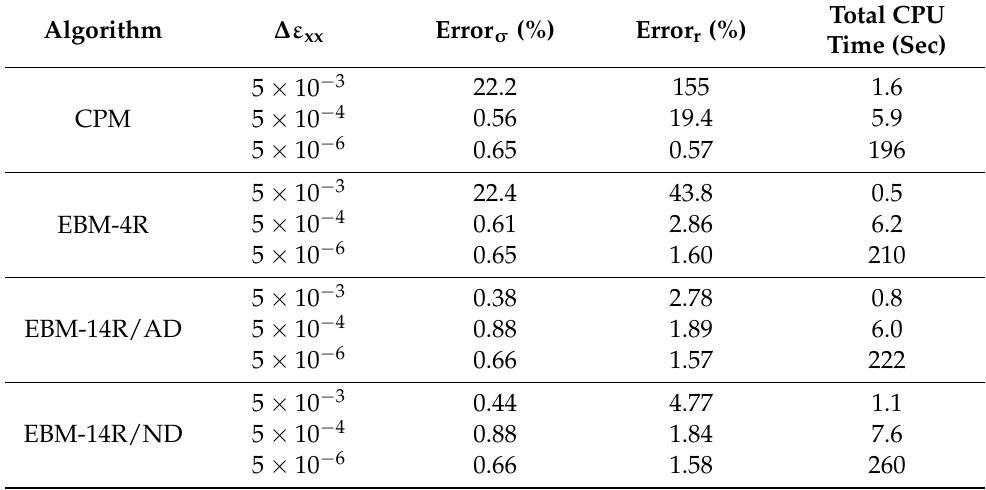
Table 5. Average relative errors in the flow curves and r-values of MAT 1 under C5T10CR.